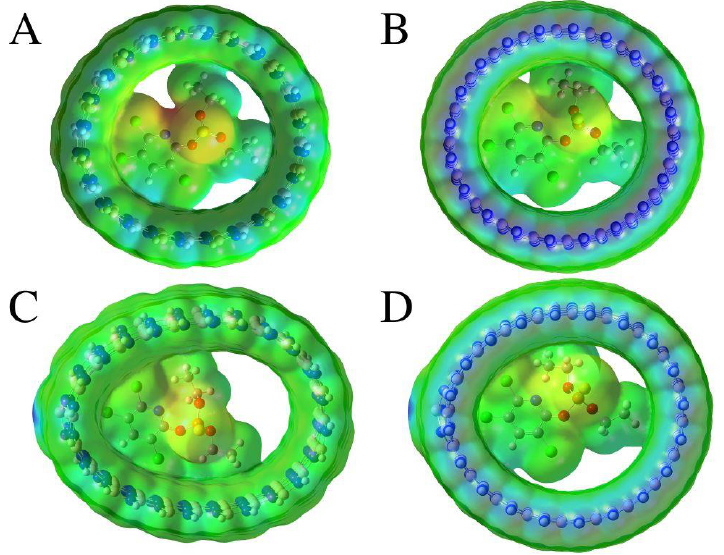
Figure 2. Electrostatic potentials of ( A ) BNNT(12,12) + chl, ( B ) BNNT(20,0) + chl, ( C ) Al-BNNT(12,12) + chl, and ( D ) Al-BNNT(20,0) + chl.